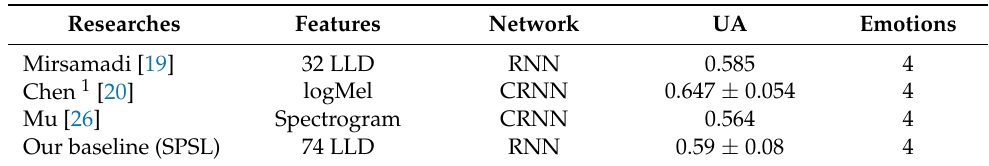
Table 5. Performance results reported in previous recurrent neural networks (RNN)-based studies of SER model and our baseline model based on IEMOCAP.